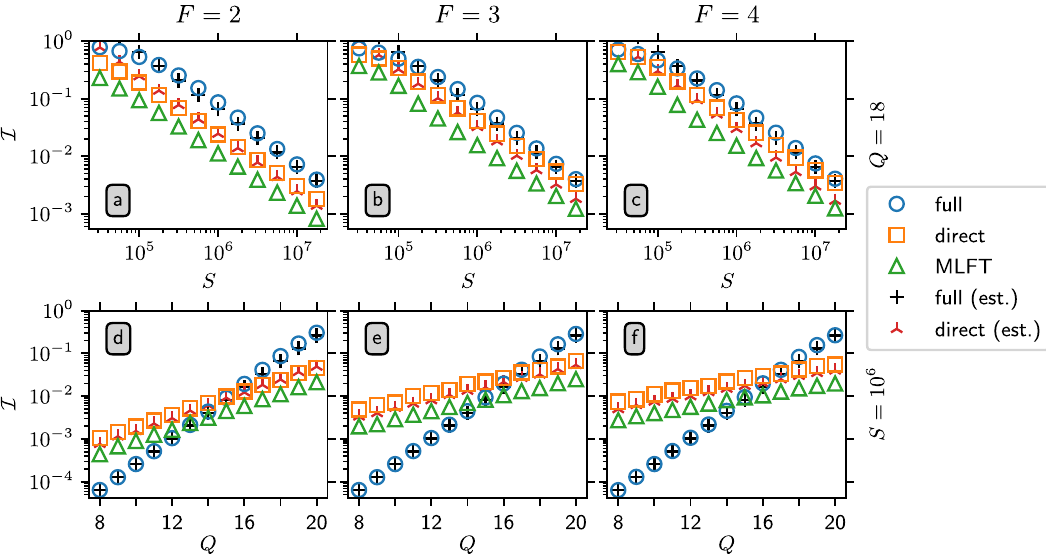
Fig. 5 In fi delity in reconstructed circuit outputs. The in fi delity I ¼ 1 (cid:4) F as a function of sample number S ( a – c ) or qubit number Q ( d – f ) for clustered random unitary circuits (RUCs) with F = 2 ( a , d ), 3 ( b , e ), or 4 ( c , f ) fragments. Open markers correspond to simulations of the full circuit ( “ full ” ), or simulations via circuit cutting before ( “ direct ” ) and after ( “ MLFT ” ) maximum-likelihood corrections to fragment models. The last two markers in the legend correspond to analytical estimates of in fi delity: 2 Q / S for the full method, and where C f is the number of classical outputs on fragment f and n = S / V is the number of samples devoted to each of V total fragment variants. o Whereas the estimates for the full method are quantitatively accurate, the estimates for the direct method are provided only to highlight approximate scaling relationships (Supplmentary Information). Results for each data point are averaged over 100 instances of a clustered